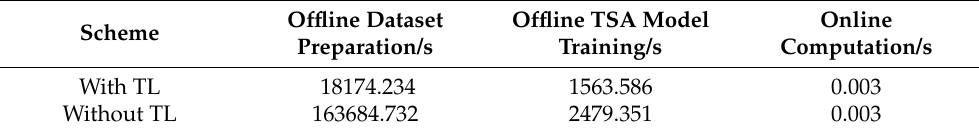
Table 3. Summary of Computation Times (with/without